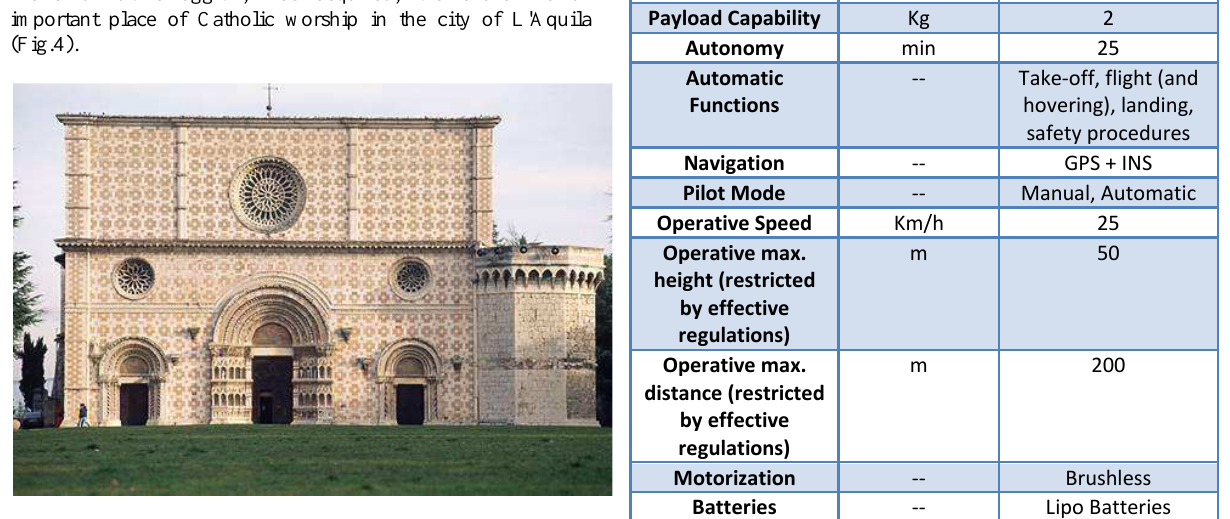
Figure 4. The Basilica di Santa Maria di Collemaggio